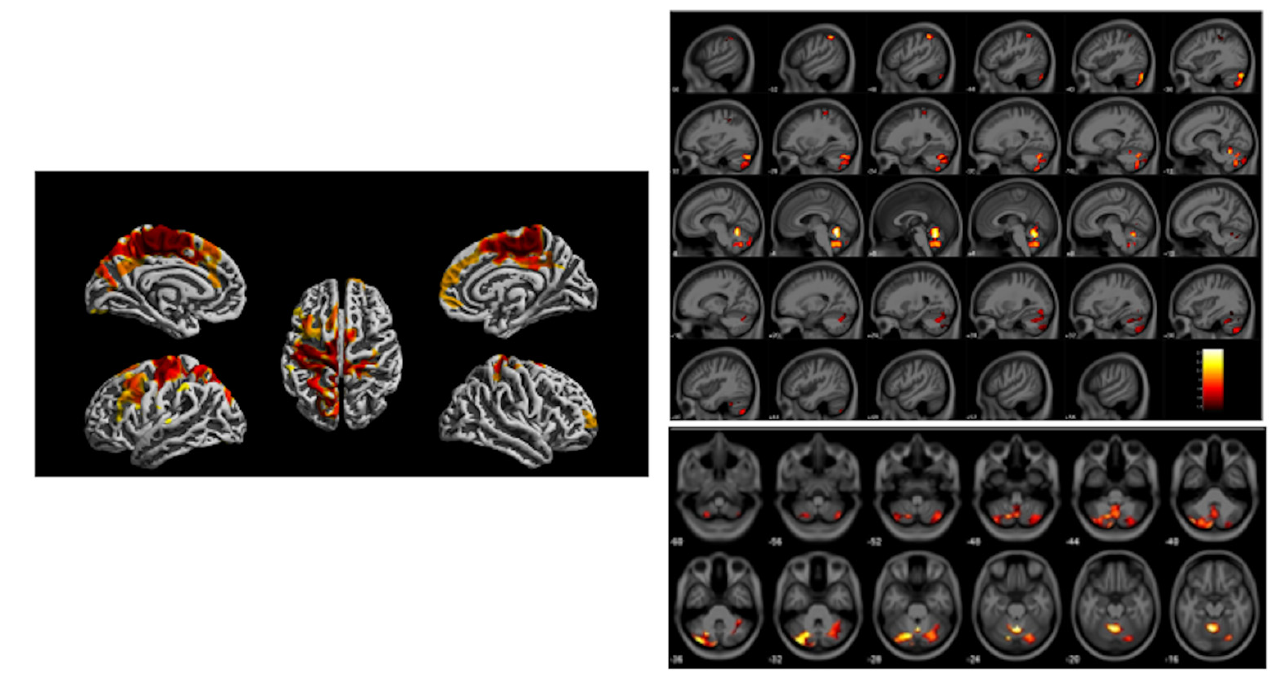
Figure 6. Imaging findings acquired from a 3 Tesla scanner at age 12 years from the Cincinnati Childhood Allergy and Air Pollution Study (CCAAPS) comparing high and low groups based upon estimated element carbon attributable to traffic (ECAT) exposure in the first year of life. Left, regions illustrated in red and yellow on brain renderings oriented with different views demonstrate regional reduced cortical thickness. Right, regional gray matter volume loss illustrated across the brain in a sagittal view (top) and axial view showing cerebellar region (bottom) associated with the high ECAT group compared to the low ECAT group. Clusters were corrected for multiple comparisons using threshold free cluster enhancement with a familywise error rate of p < 0.05. Color bar represents - log ( p ) value from 1.4 to 2.6.